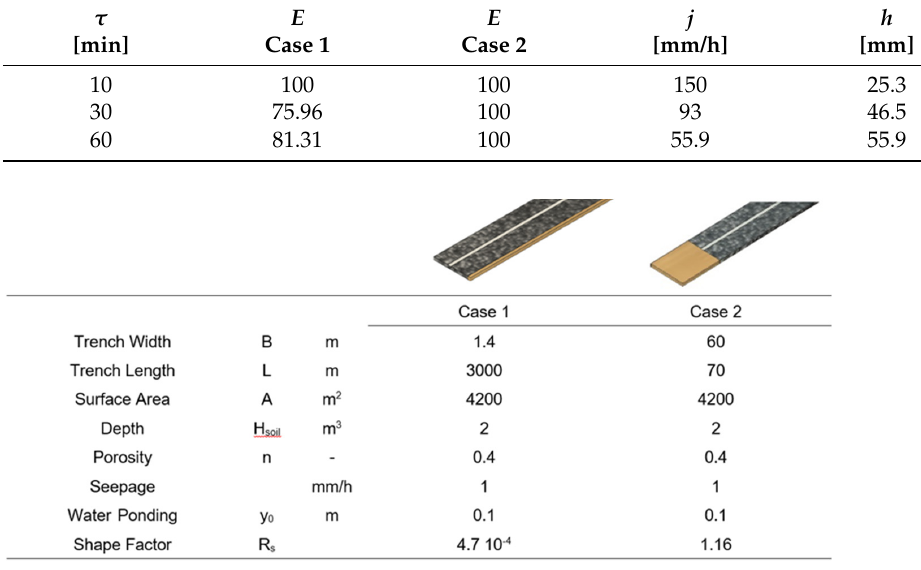
Figure 2. Two realizable ISs with same area ratio R a = 43 and different shape factors R S = 4.7 × 10 − 4 ( left ) and R S = 1.16 ( right